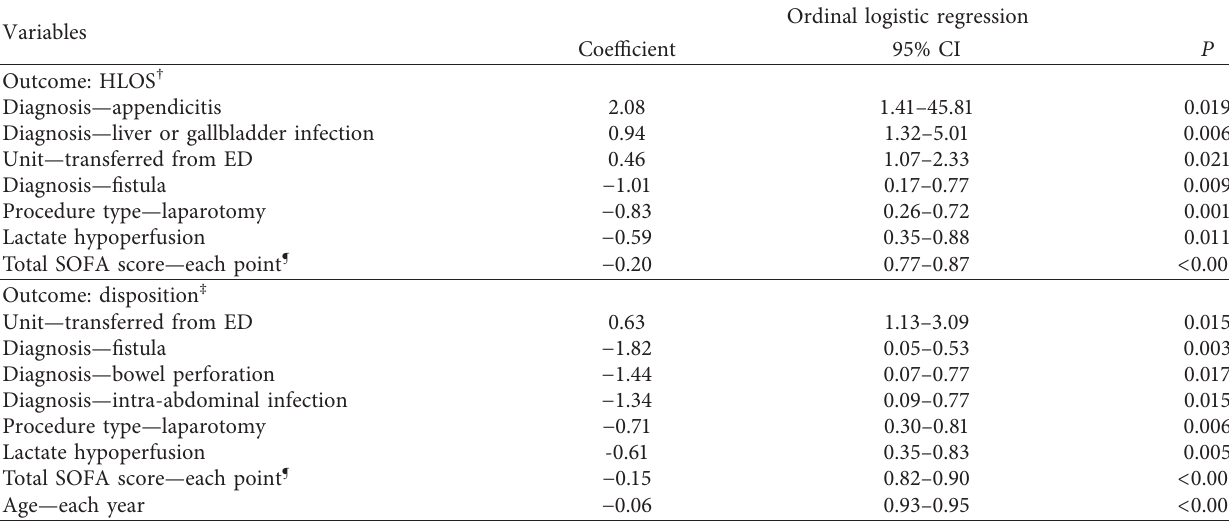
Table 5: Multivariable ordinal logistic regression measuring association of clinical factors with patients’ outcomes of HLOS and disposition. The order for HLOS was 0 (short, ≤ 5 days), 1 (medium, > 5 days to ≤ 12 days), and 2 (long, > 12 days). The order for disposition was 1 (home), 2 (rehab or subacute facility), 3 (skilled nursing facility), and 4 (discharge to hospice or death). All independent variables selected a priori were included in the models; only variables that were statistically significant were reported.